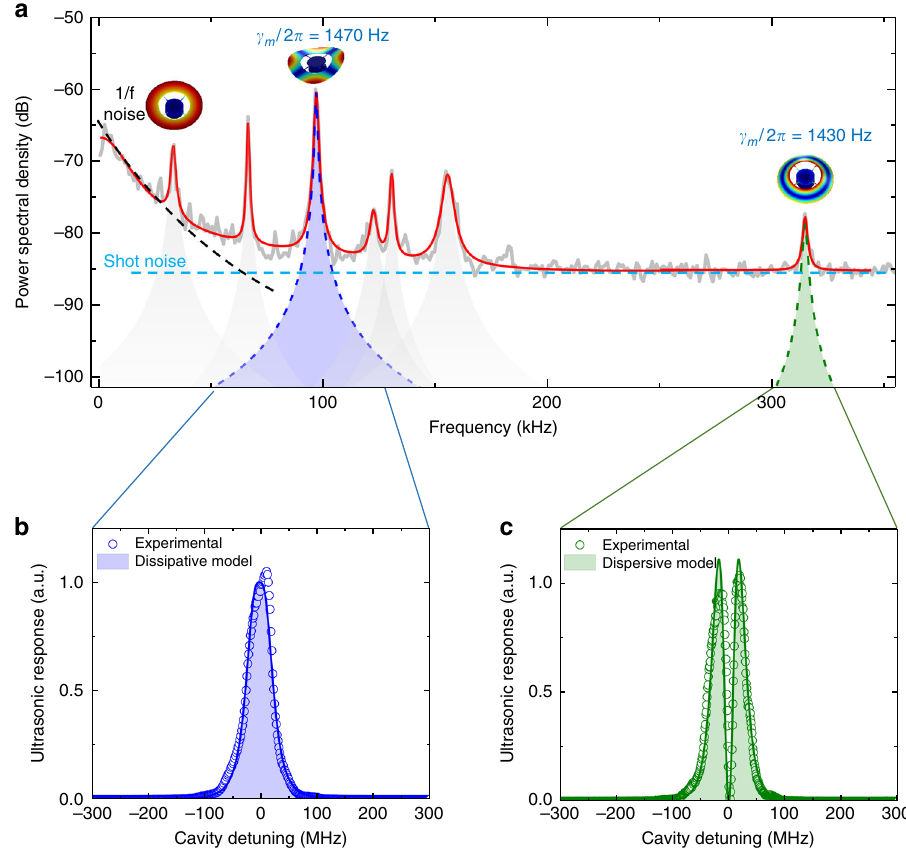
Fig. 3 Noise spectrum and coupling mechanisms. a The noise spectral density of the microdisk coupled to the tapered fi bre in the absence of acoustic signal. The blue dashed line speci fi es the shot noise level given by the laser intensity, and the black dashed line corresponds to the 1/ f noise. The shaded Lorentzian peaks specify the combined noise due to intrinsic damping and gas damping for several mechanical modes of the device. The green and blue shading highlights examples of dispersively and dissipatively coupled mechanical modes, respectively. γ m quanti fi es the total mechanical dissipation rate of each of these modes, including both gas and intrinsic damping. b , c The ultrasonic response as a function of laser-cavity detuning at frequencies of 98 and 315 kHz, resonant with the second-order crown and fl apping modes of the disk, respectively. The shaded areas are fi ts based upon the theoretical expectation for system response as function of detuning (see Supplementary Fig. 1) corresponding to dissipative ( b ) and dispersive ( c ) coupling,